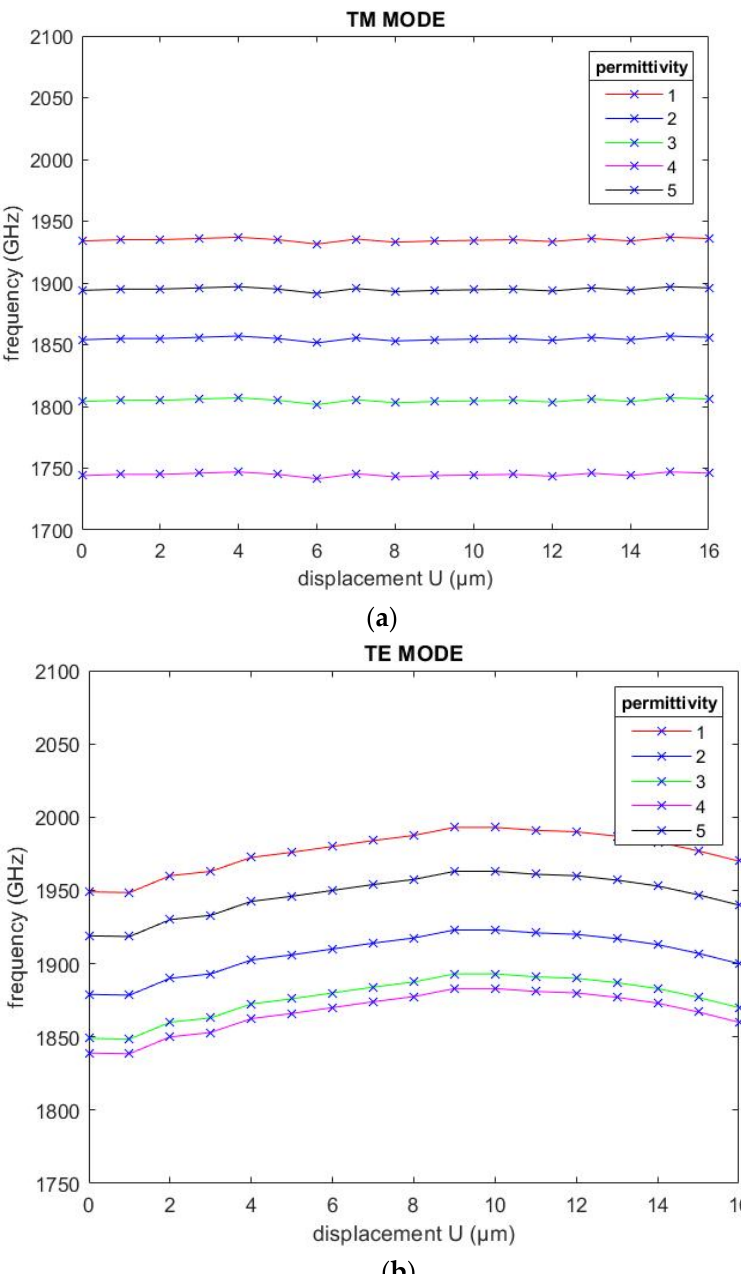
Figure 11. Resonant frequency change as a function of permittivity of an additional layer—2D plot in case of: ( a ) TM mode, ( b ) TE mode.